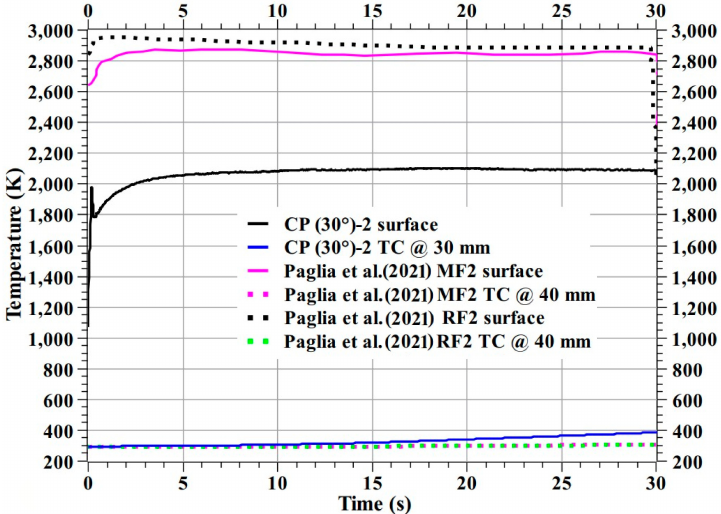
Figure 33. Comparison of CP (30 ◦ )-2 and Paglia et al. carbon phenolic ablators temperature responses [5]. Comparing recession rates, the CP (30 ◦ )-1 specimen’s stagnation point recession rate is 2.4-fold greater than the predicated stagnation point recession rate of the Milos et al. specimen; When compared to the Paglia et al. specimens, CP (30 ◦ )-2 specimen’s stagnation point recession rate is 0.54-fold lower and mass loss rate is 0.6-fold lower. Milos et al. did not publish their mass loss rate; hence a comparison with their mass loss rate is not made here. In other words, it can be said that the 30 ◦ carbon phenolic ablator’s recession